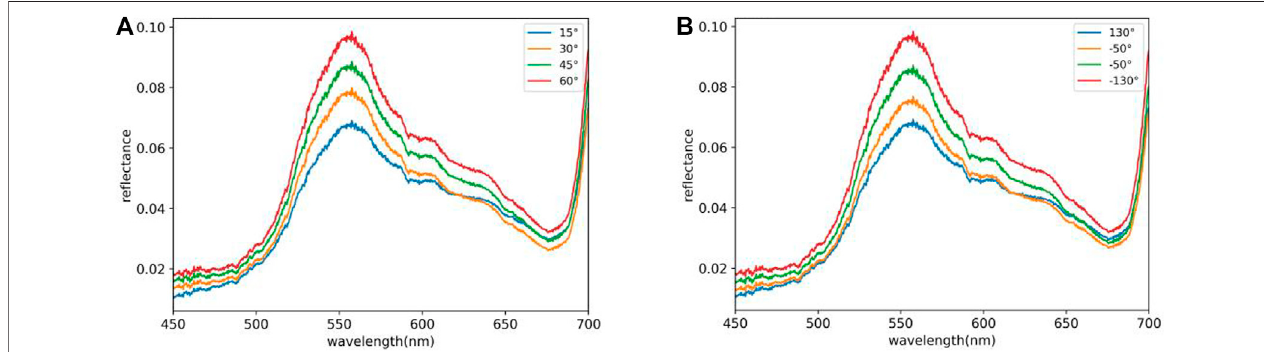
FIGURE2| Multi-anglere fl ectancewithin15 minat10:30a.m.onAugust29(ZAAwasabout47.2 ° ),2018; (A) variousOZAwithOAAat − 130 ° and (B) variousOAA with OZA at 60 °